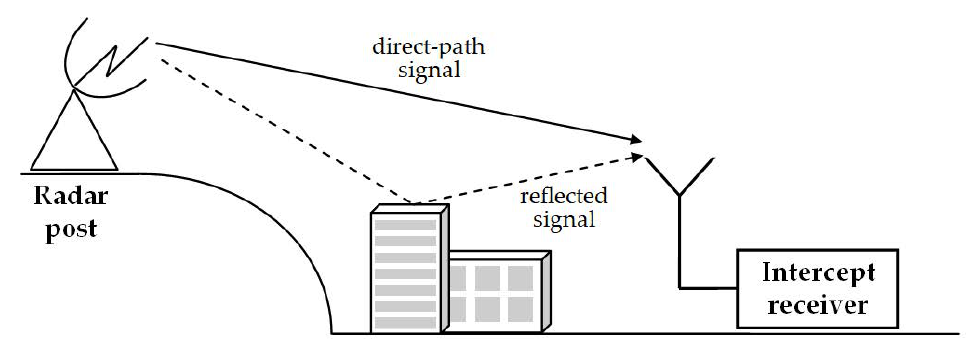
Figure 3. Schematic explanation of multipath phenomenon with a single